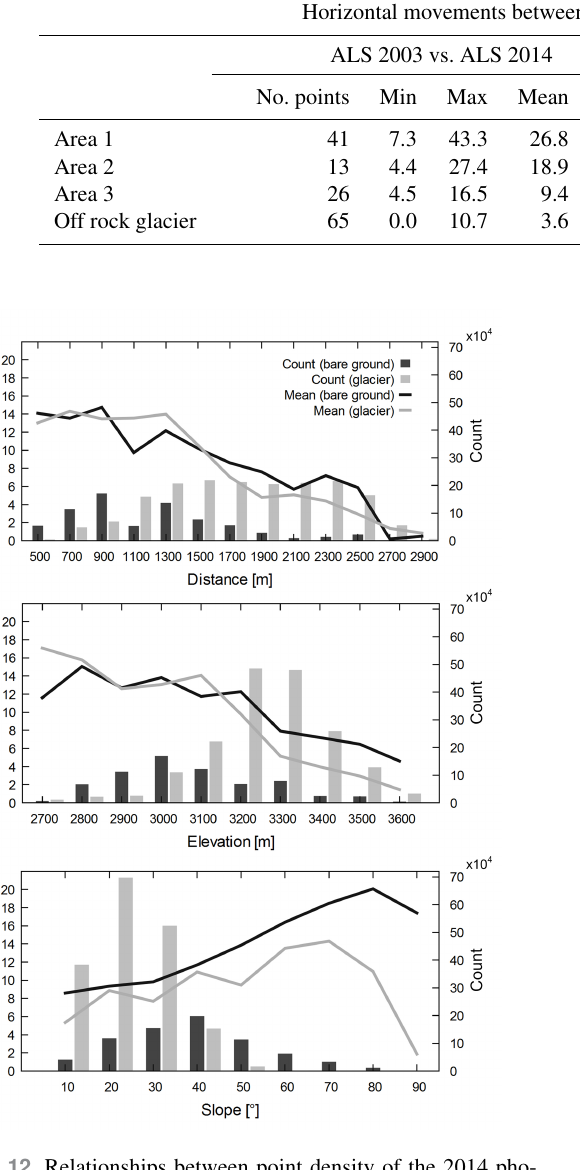
Figure 12. Relationships between point density of the 2014 pho- togrammetric 3-D model and (a) camera–object distance, (b) ele- vation and (c) slope calculated for the glacier and rock stable area outside glacier. The point density was estimated using the filtered and subsampled point